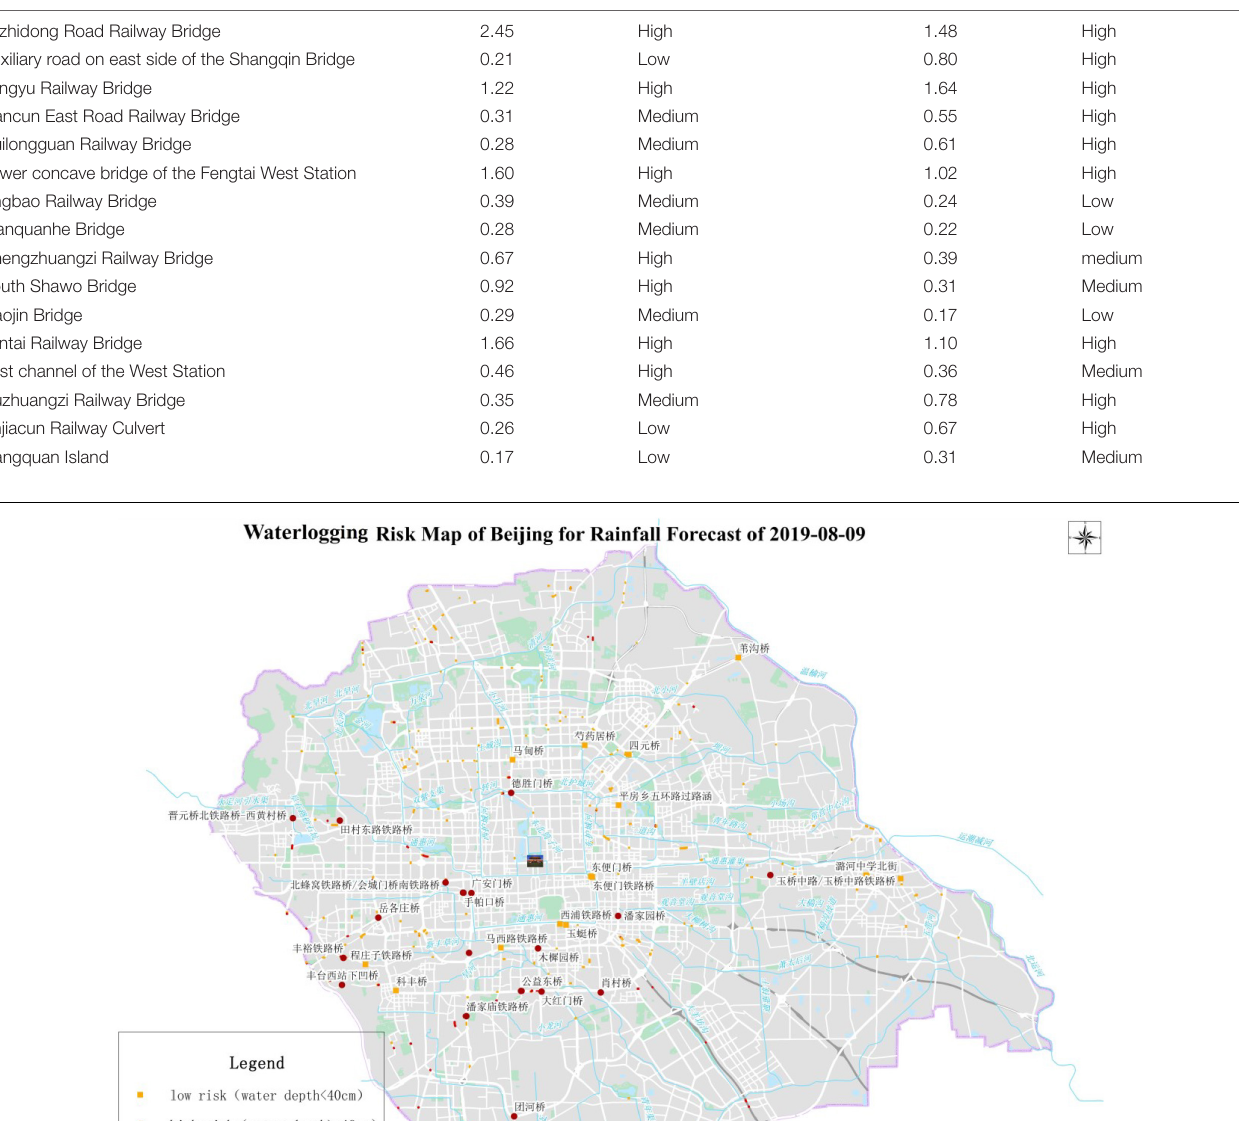
TABLE 2 | The simulated and the measured depth of waterlogging of the 2020-08-12 rainstorm. Location